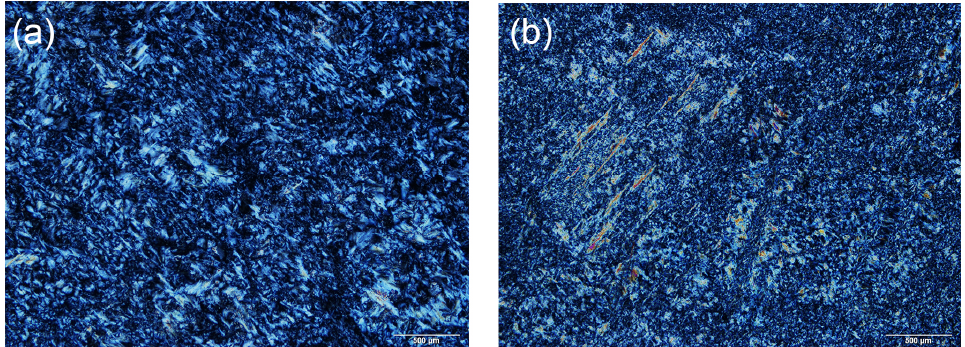
Figure 2. Microstructures of bluish-green serpentinite under crossed-polarised light. ( a ) Serpentinite with interpenetrating structure. ( b ) A few leaf-shaped serpentine-type minerals arranged direc- tionally.